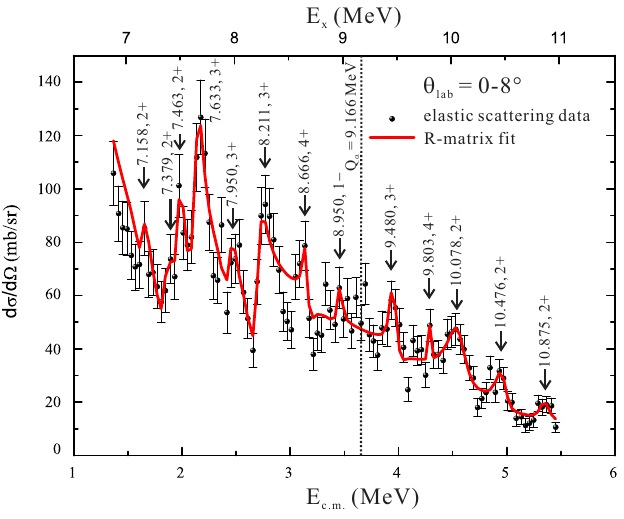
Figure 3. Excitation function of 25 Al + p elastic scattering at θ lab = 0-8 ◦ . The red curve represents the best overall R-matrix